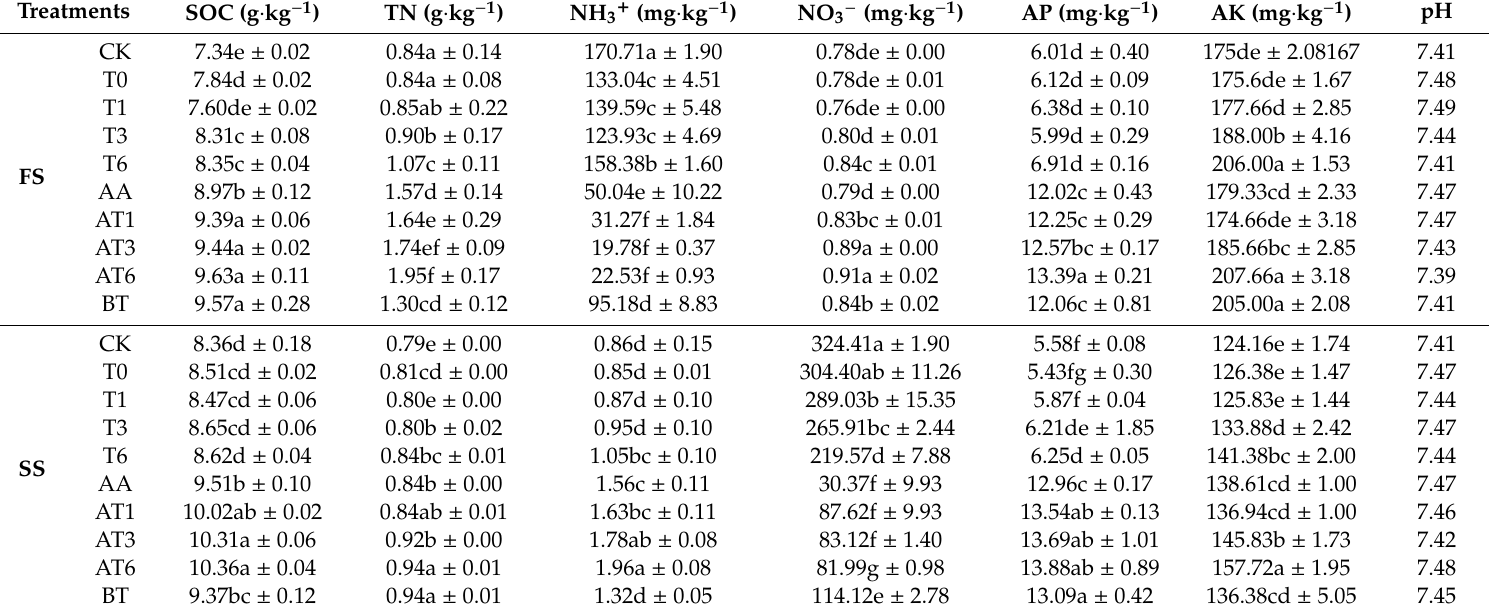
Table 4. The physiochemical characterization of red soil during two seasons after the harvest.